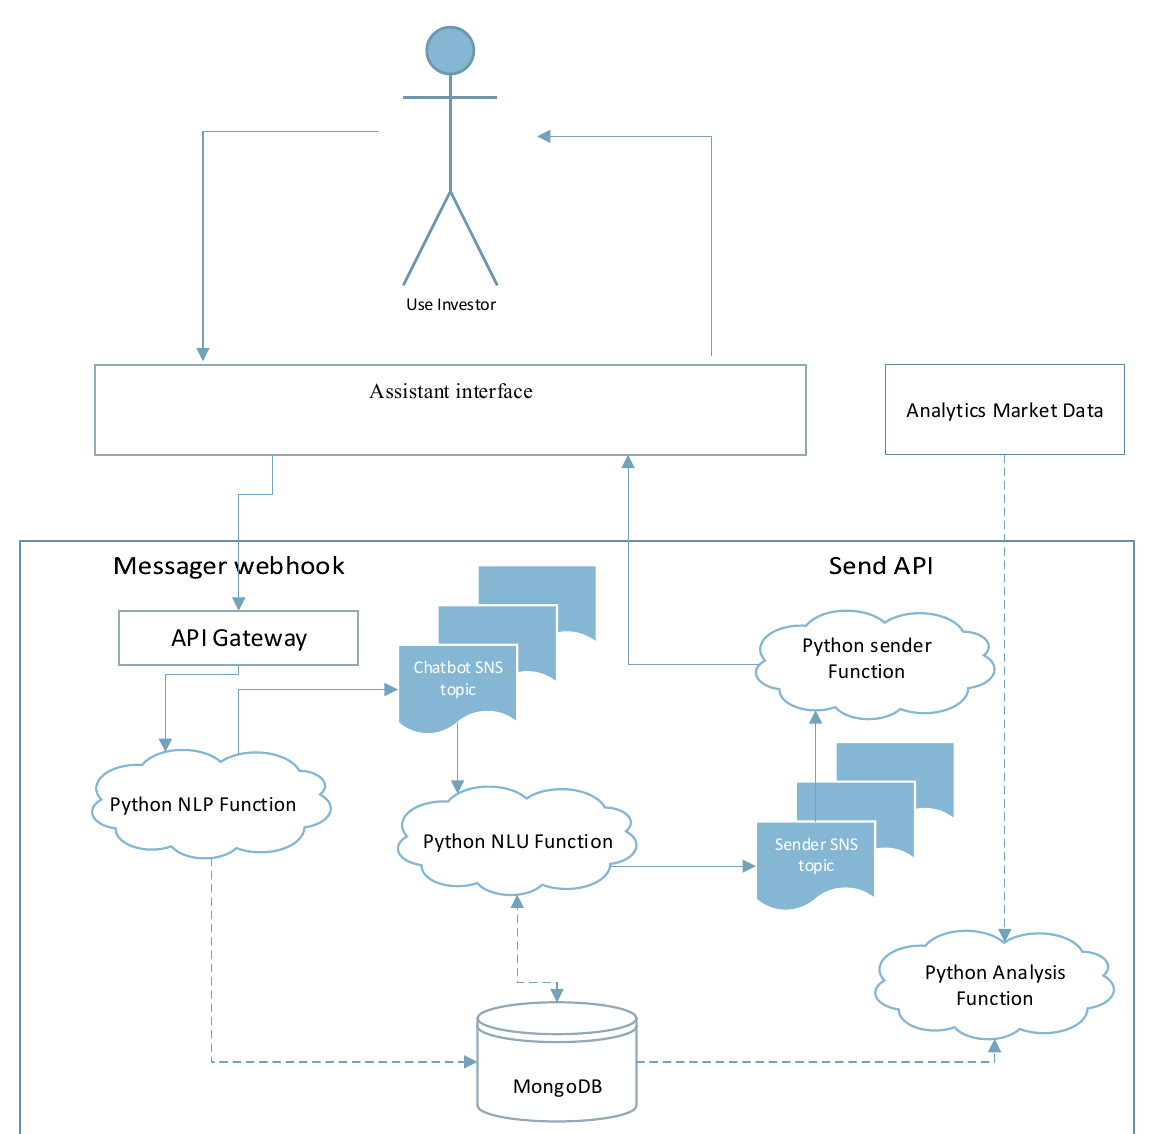
Figure 4. Proposed architecture of the Operational Solution Assistant system.